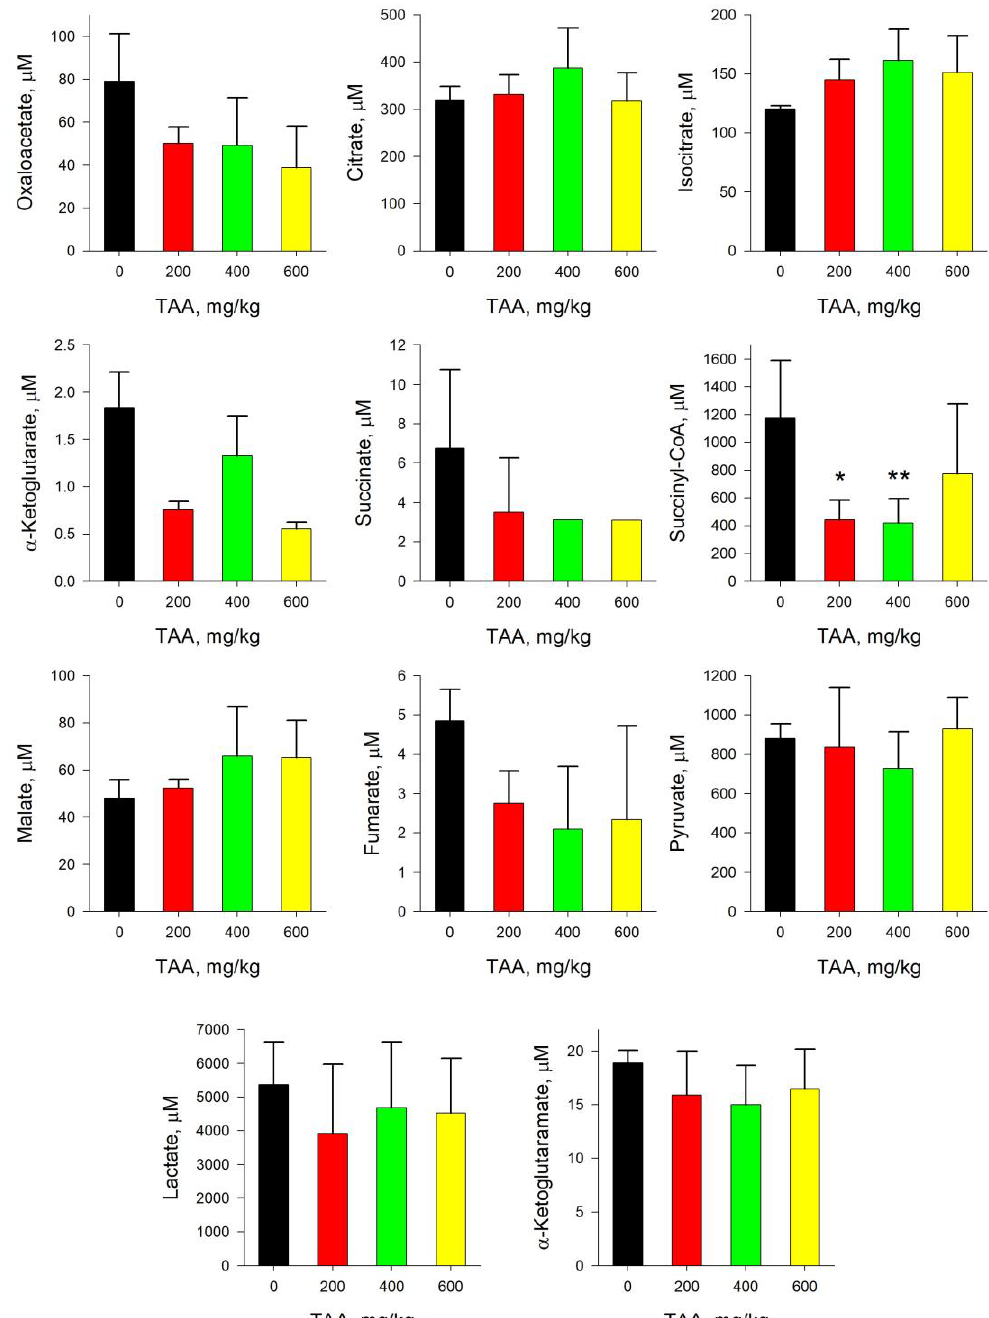
Figure 1. Concentration of TCA cycle and associated metabolites in the blood plasma of control and TAA-treated rats (AVG ± STDEV, µM). p -values by Tukey ’s test: * — p < 0.1; ** — p < 0.05; black stars mean a pairwise comparison to control (for details see Table and Figures in Supplement S1).